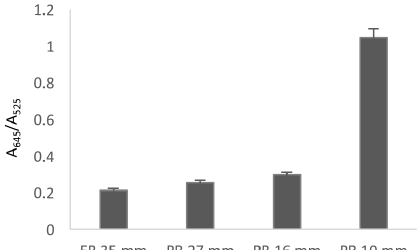
Figure 8. Comparison of formaldehyde emission between fibrous boards (FB) and different particle board (PB) using AuNP-1 (two replicate experiments were performed).